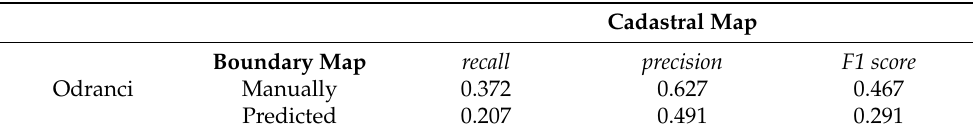
Table 6. Assessment of the overlap between cadastral boundaries and land visible boundaries—